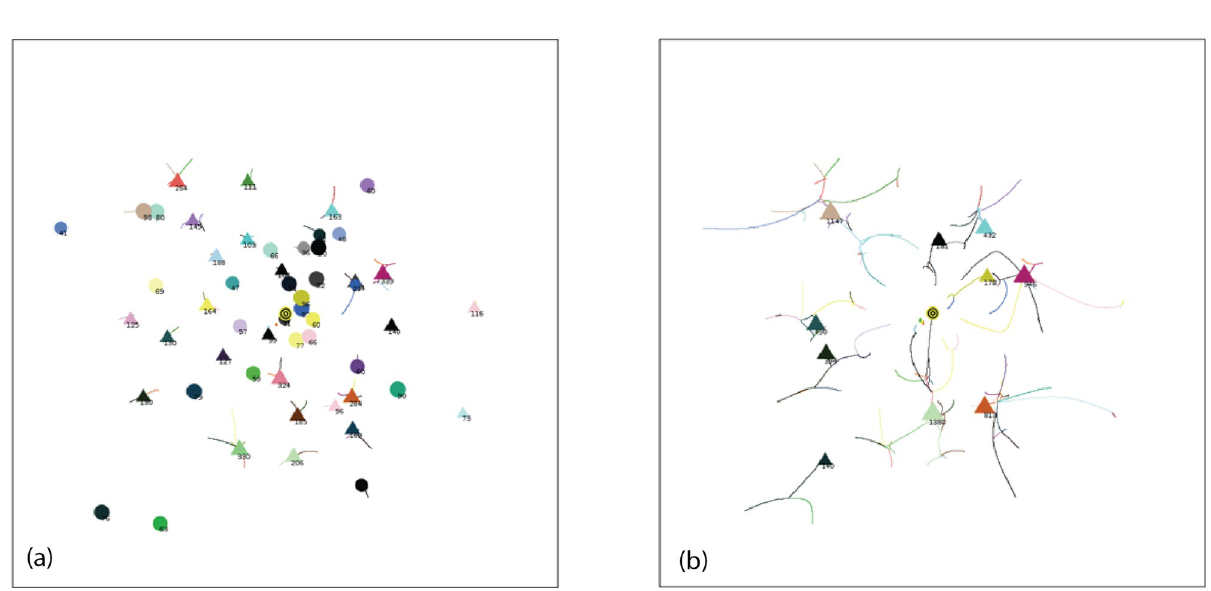
Fig 8. Simulation at 10% ET of completion. Groups = triangles, individual agents = circles. Standard initial conditions. Seed = 61. a) AIB = 30, ET = 680, 27 individuals(circles), 26 groups(triangles), MDCN = 12, repulsive force < 0.5%, DT < 5. b) AIB = 180, ET = 5490, 10 groups, MDCN = 21, repulsive force < 20%, DT < 17. For animation for 30 AIB: https://youtu.be/WzblcRCjiK8.